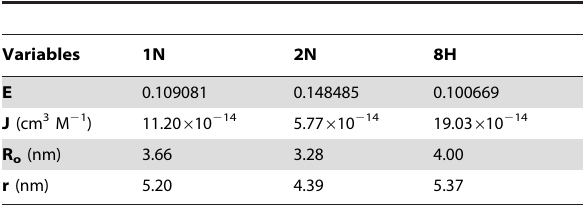
Table 4. FRET data obtained from spectral overlap of HSA emission and pollutant